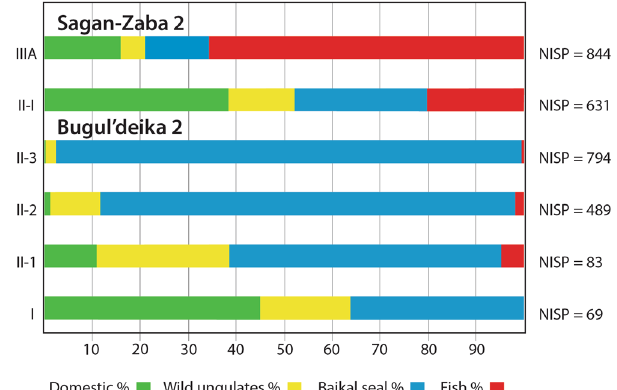
Figure 3. Identified faunal remains from the Sagan-Zaba 2 and Bugul’deika 2 habitation sites. Analytical unit designations are given on the left margin, and the numbers of identified specimen (NISP) values for each analytical unit are listed on the right